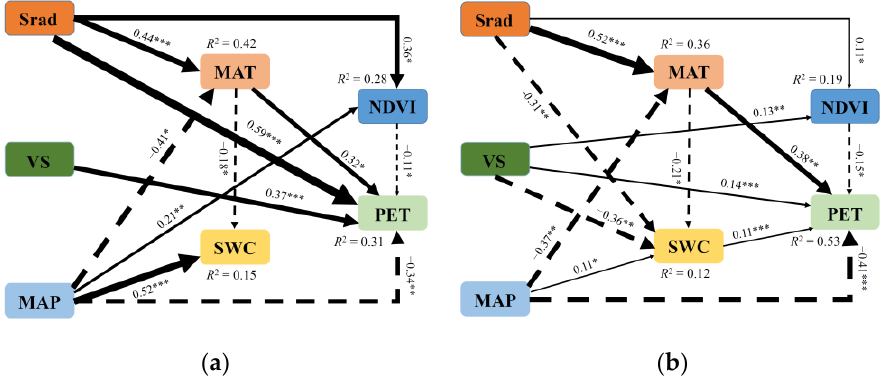
Figure 8. SEM used to assess the effect of environmental factors on PET. The solid line represents a significant positive effect, the dashed line represents a significant negative effect and, if there is no significant relationship between variables, the line is omitted. *: P < 0.1; ** P < 0.05; *** P < 0.01.